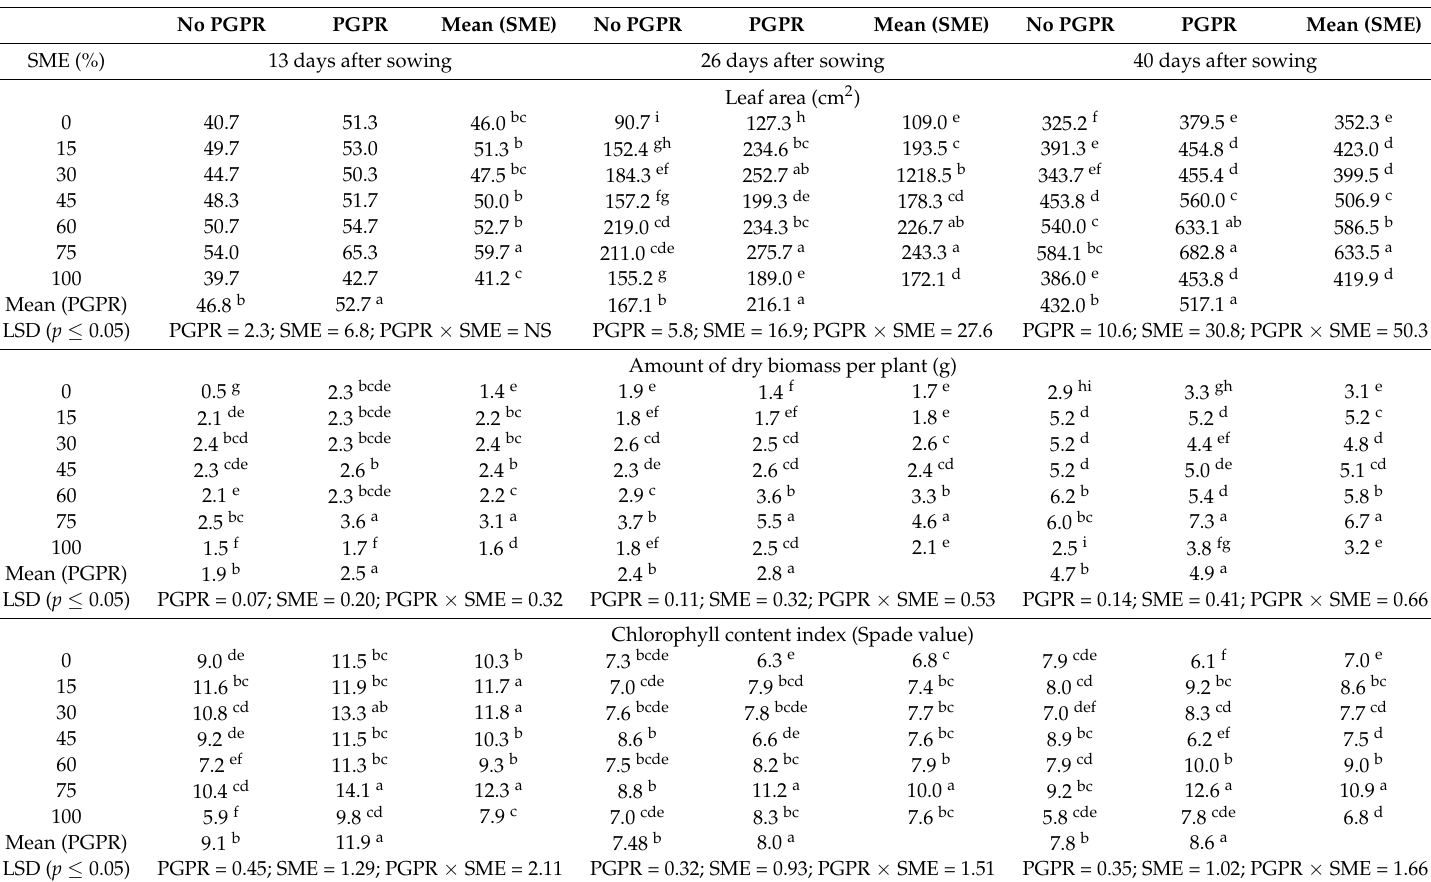
Table 2. Influence of diluted sugar mill effluent and PGPR on size of leaf area, amount of dry biomass per plant and chlorophyll content of